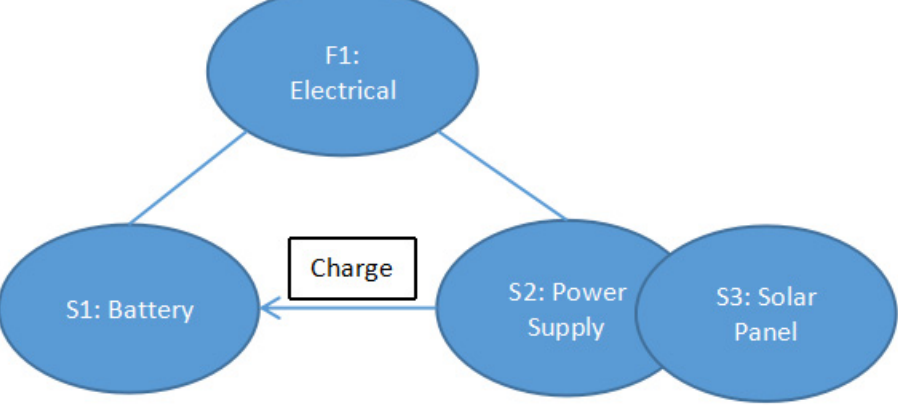
Figure 7. Improved Su-field model for constraint 2.